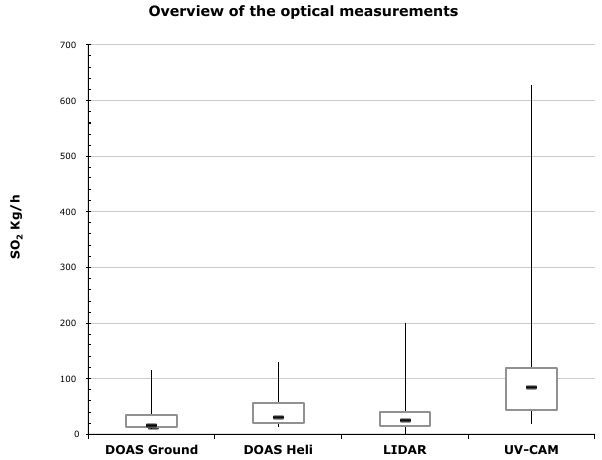
Figure 5. Emission values observed by the different optical mea- surement techniques during the SIRENAS-R campaign. The bars indicate the maximum and minimum values, the squares indicate the 25th and 75th percentile and the dark line is the median of the measurement distribution.